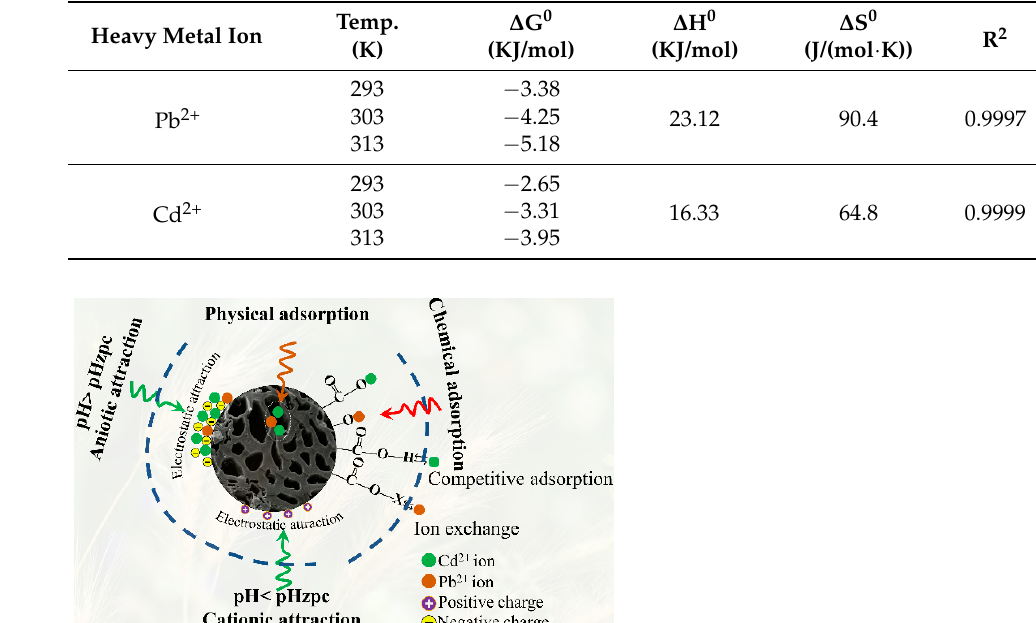
Figure 13. The thermodynamic adsorption curve of Pb ( a ) and Cd ( b ) ions by MAC. Table 8. Thermodynamic parameters of MAC adsorption of heavy metal ions.